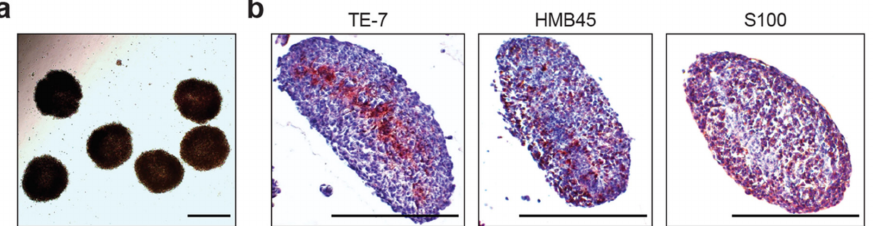
Figure 1. Melanoma heterogeneous spheroids ( a ) of typical regular morphology harvested for experiments. Spheroids display consistent localisation of melanoma cells on the periphery and fibroblasts in their core. The spheroids show structural inhomogeneity with fibroblasts marked by TE-7 antibody in their core and melanoma cells on their periphery visualised by HMB45 and S100 markers ( b ). The bar denotes 1000 µ